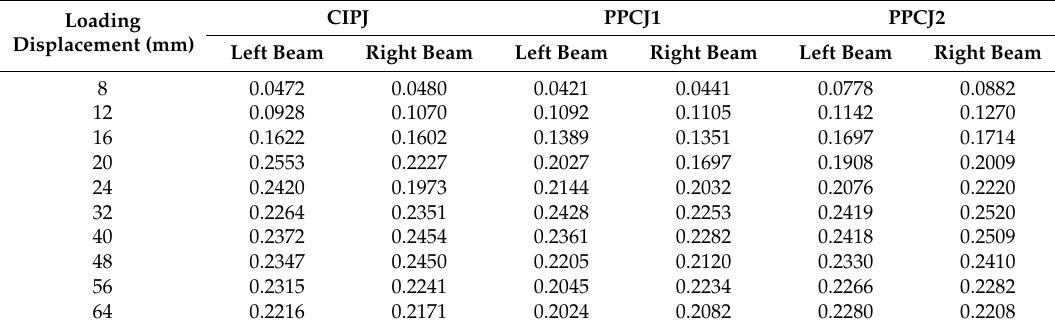
Table 4. Equivalent viscous damping coefficients of the test joints.